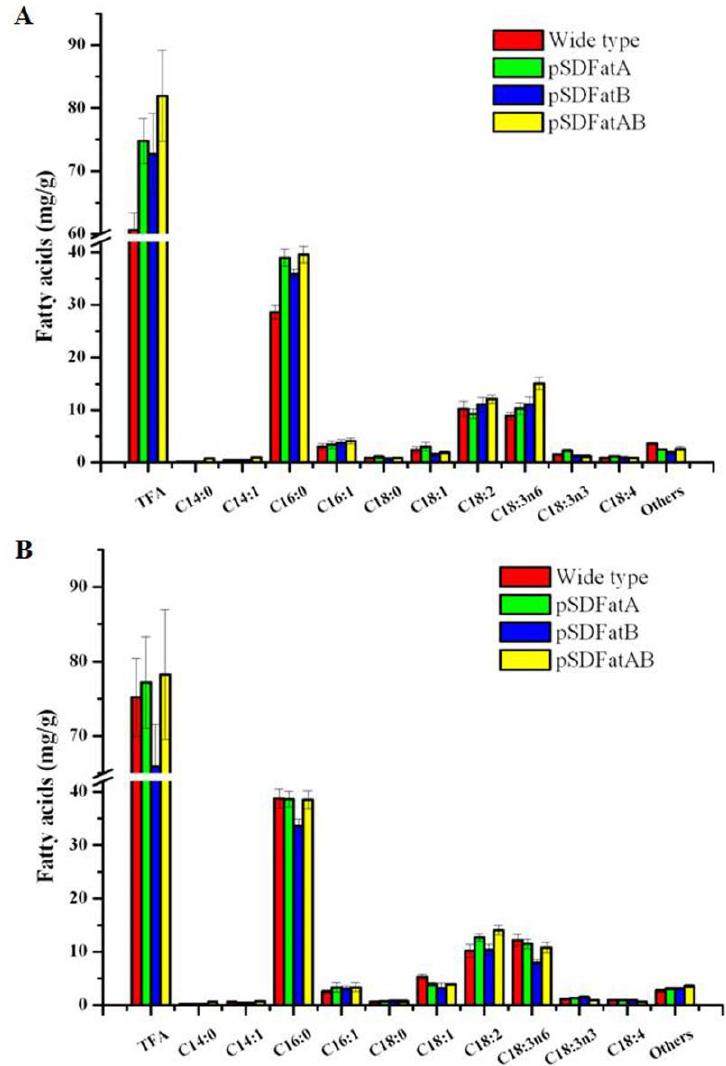
Figure 5. Fatty acid content of wild-type and transgenic Synechocystis sp. PCC6803 a cultured under mixotrophic growth conditions at ( A ) 20 °C and ( B ) 30 °C. TFA: Total fatty acids; FA: fatty acids. a Values are means and S.D. of triplicate experiments. Cells were grown under a light intensity of 40 μmol photon m −2 s −1 for 10 d in BG-11 medium. The membrane lipids were extracted from the wild-type and genetically engineered Synechocystis sp. PCC6803. The enzymes overexpressed are indicated in parentheses ( FatA : Acyl-ACP Thioesterase A from ‘Luhua 14’ cultivar of Arachis hypogaea